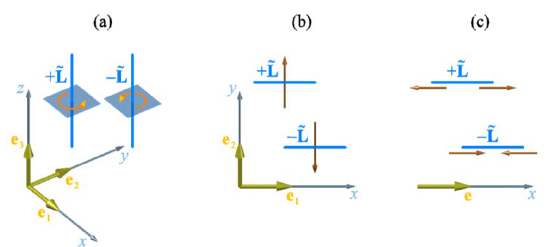
Figure 28: The two outer orientations (positive and negative ori- entations) of a line in three-dimensional, two-dimensional, and one-dimensional spaces.